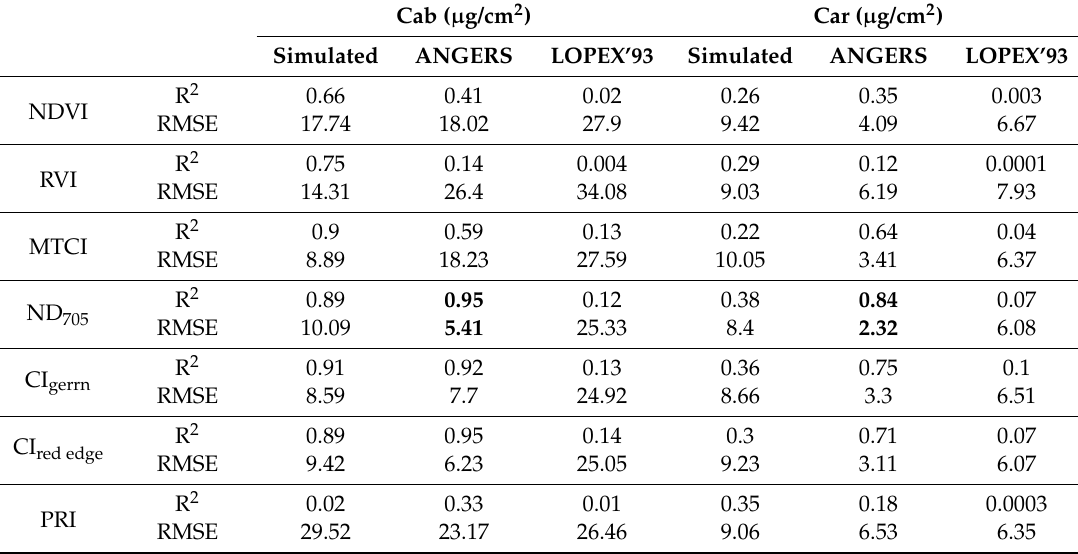
Table 7. Results for the validation of the accuracy of the VI-based models of chlorophyll content (Cab) and carotenoid content